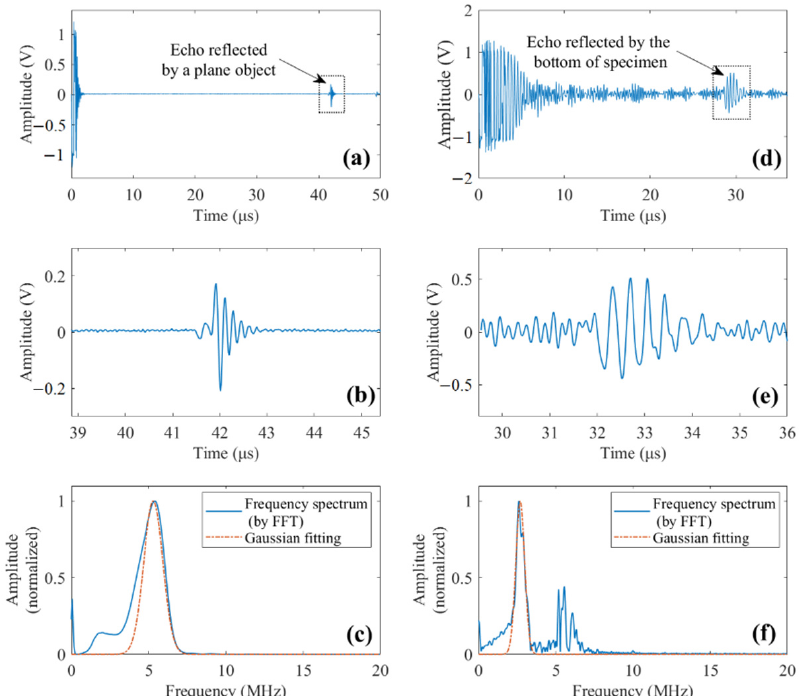
Figure 7. ( a ) Plane-reflected waveform. ( b ) The pulse reflected by a plane object. ( c ) Original and Gaussian-fitted frequency spectrum of the plane-reflected pulse. ( d ) Waveform of an experimental signal. ( e ) Bottom-reflected echo. ( f ) Original and Gaussian-fitted frequency spectrum of the bottom- reflected echo.